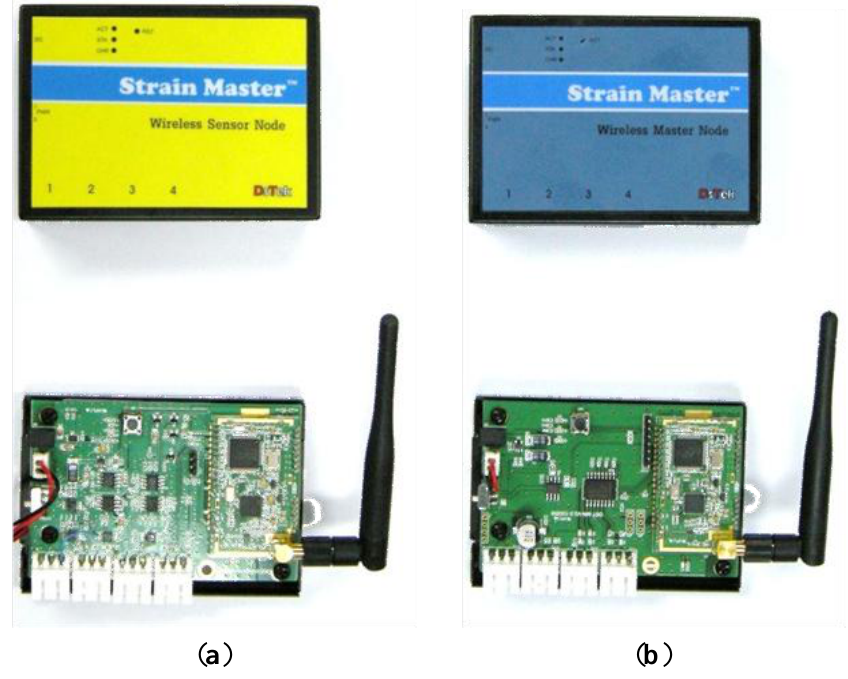
Figure 3. Sensor node and master node for wireless sensing system. ( a ) Sensor node ( b ) Master